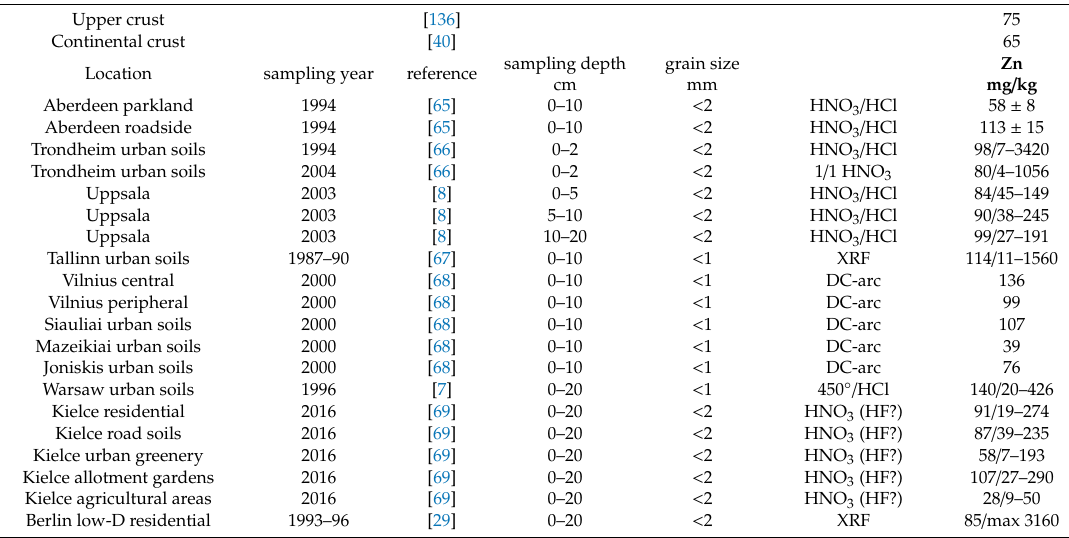
Table A20. Zinc in urban